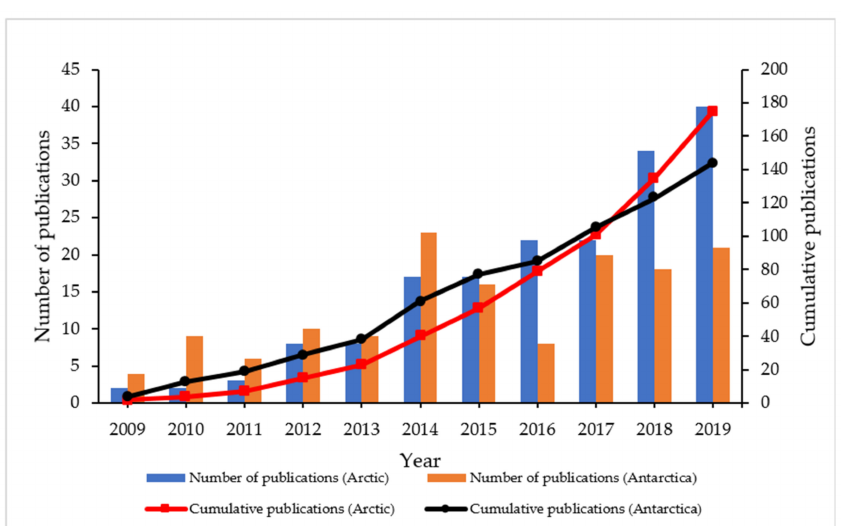
Figure 3. Number of publications from 2009 till 2019 related to hydrocarbon degradation by microbial communities in Arctic and Antarctic marine